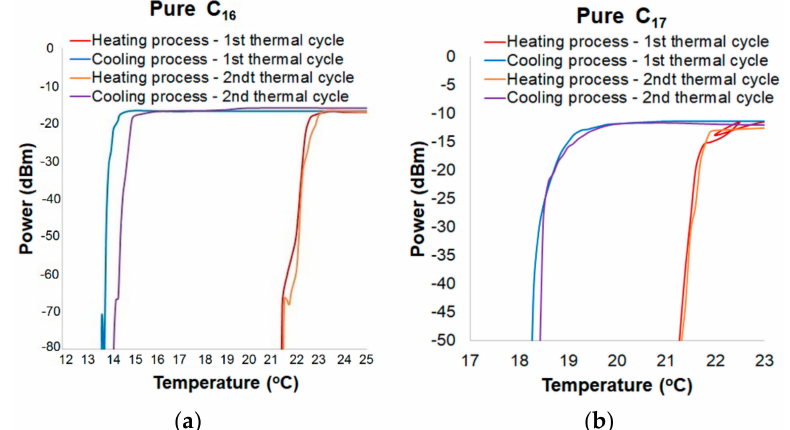
Figure 4. Changes of power transmission in tapered optical fiber (TOF) with an extra material for two thermal cycles for the measured samples: ( a ) pure C 16 and ( b ) pure C 17